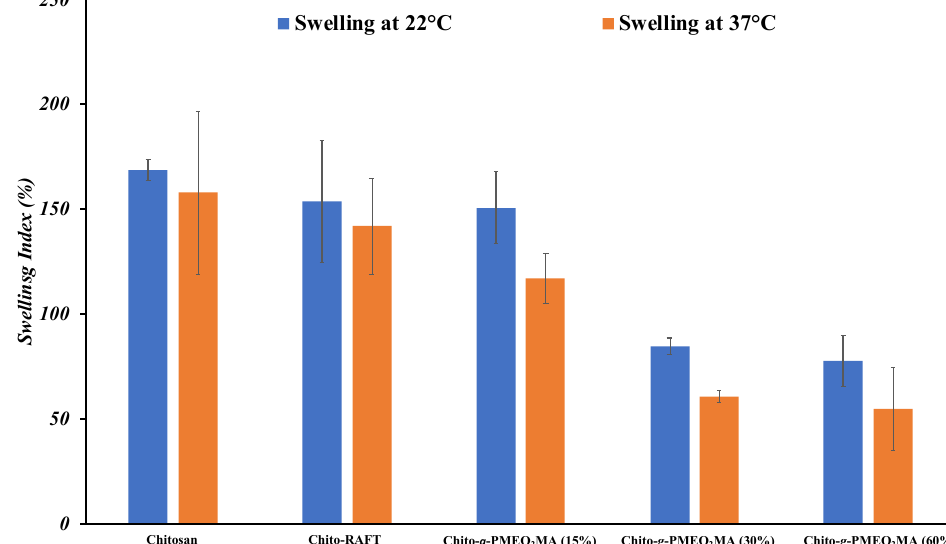
Figure 4. Water uptake behavior of selected chitosan films (n = 3).